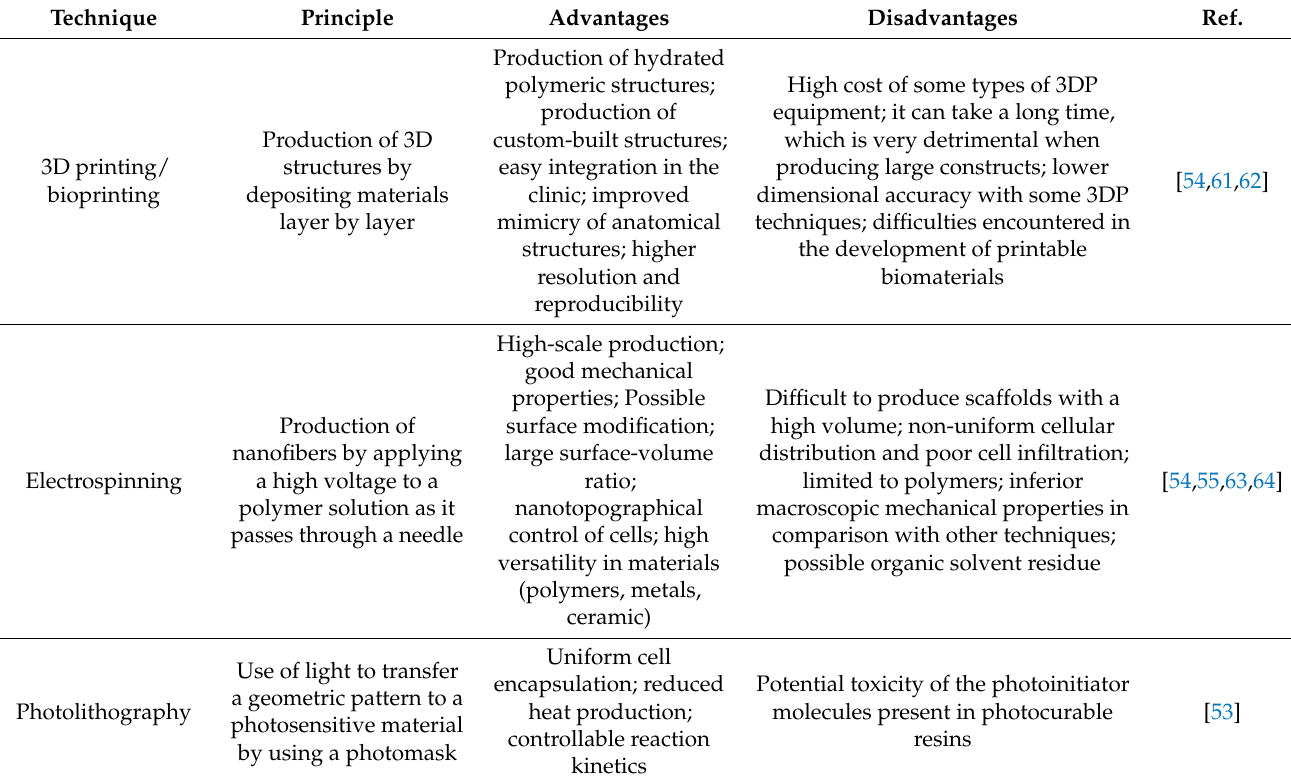
Table 2. Comparison between the different bioengineering techniques employed in the manufacture of ocular stem cell